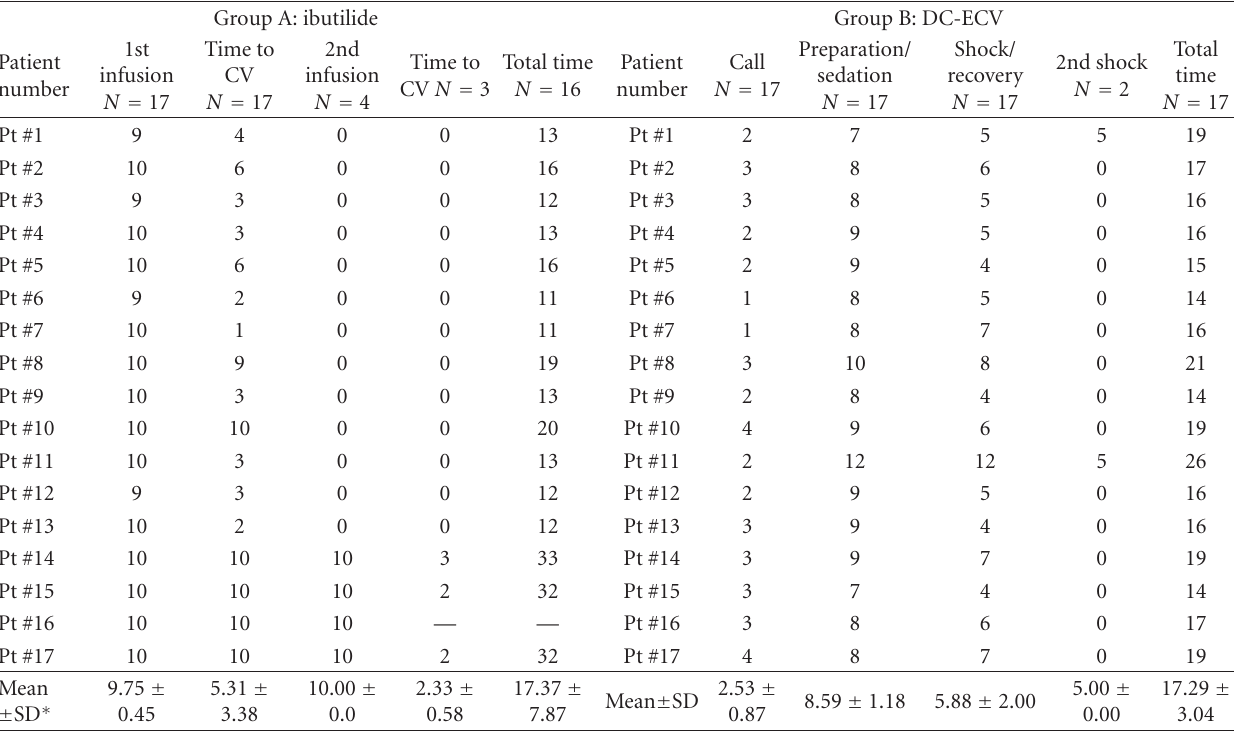
Table 2: Time intervals (in minutes) for each step of ibutilide or DC-ECV cardioversion. Group A: ibutilide Group B: